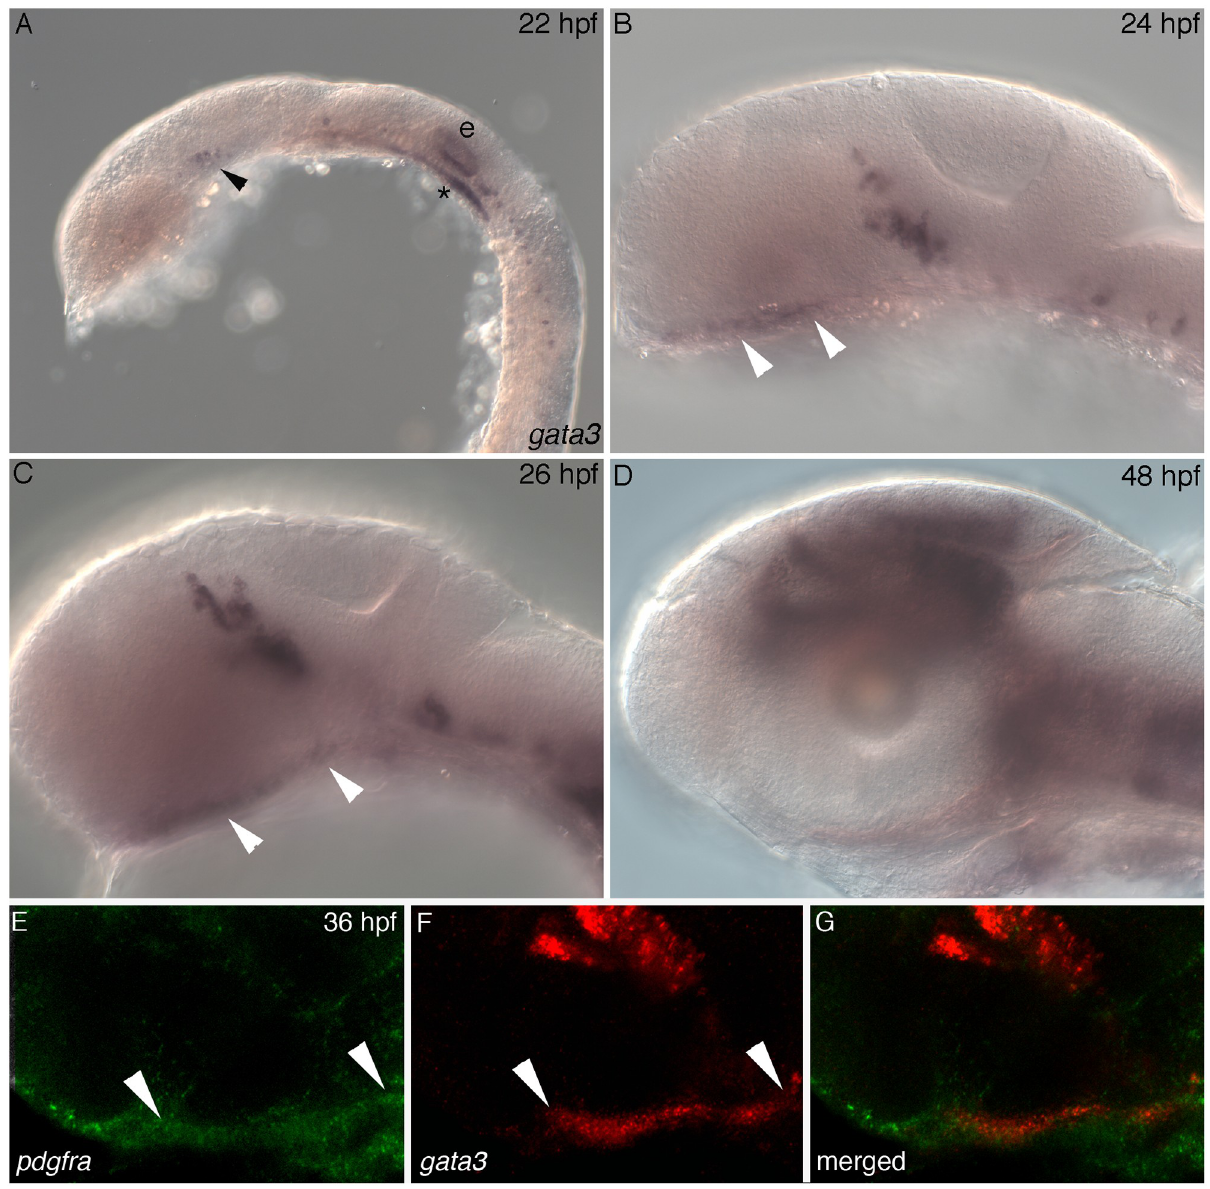
Fig 3. Dynamic expression of gata3 in maxillary neural crest cells. (A-D) Lateral views, anterior to the left, of gata3 in situ hybridization. (A) At 22 hpf, gata3 is expressed in the head in brain (black arrow), ear (e) and what is likely to be endoderm ( � ). (B) By 24 hpf, gata3 expression domains include cranial neural crest cells, which contain the trabeculae precursors (white arrowheads), the brain and neurons. (C) At 26 hpf expression continues in all previously expressing tissues. The white arrowheads indicate the cranial neural crest cells that give rise to trabeculae. (D) At 48 hpf expression begins to be down regulated in the developing palate. (E-G) RNA Scope V2 whole mount in situ hybridization at 36 hpf; white arrowheads bracket the trabeculae precursors. (E) Expression of pdgfra in cranial neural crest cells. (F) Expression of gata3 in maxillary cranial neural crest cells that will give rise to trabeculae. (G) The overlap of of pdgfra and gata3 in trabeculae precursors. chimeric on the right. While there is often phenotypic variability within an individual gata3 mutant, we find that the phenotypic score on the transplanted side was always improved rela- tive to the non-transplanted side. To determine if donor neural crest cells contribute to the res- cued trabeculae, we transplanted cells from ubi : Switch (ubiquitously labeling cells green in the